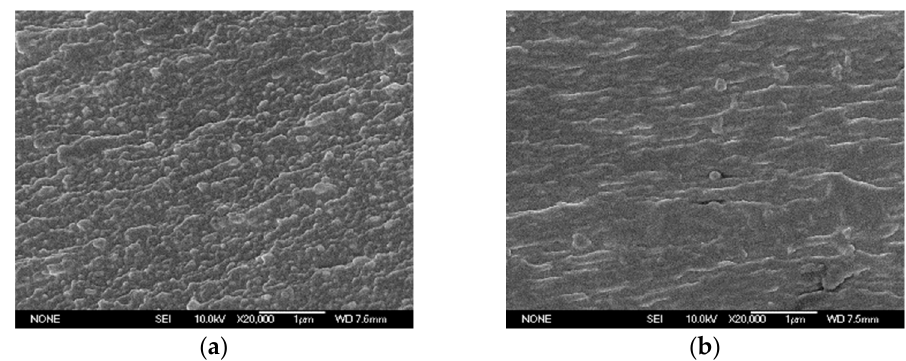
Figure 5. Surface morphology of the film. ( a ) G0, ( b ) G5.